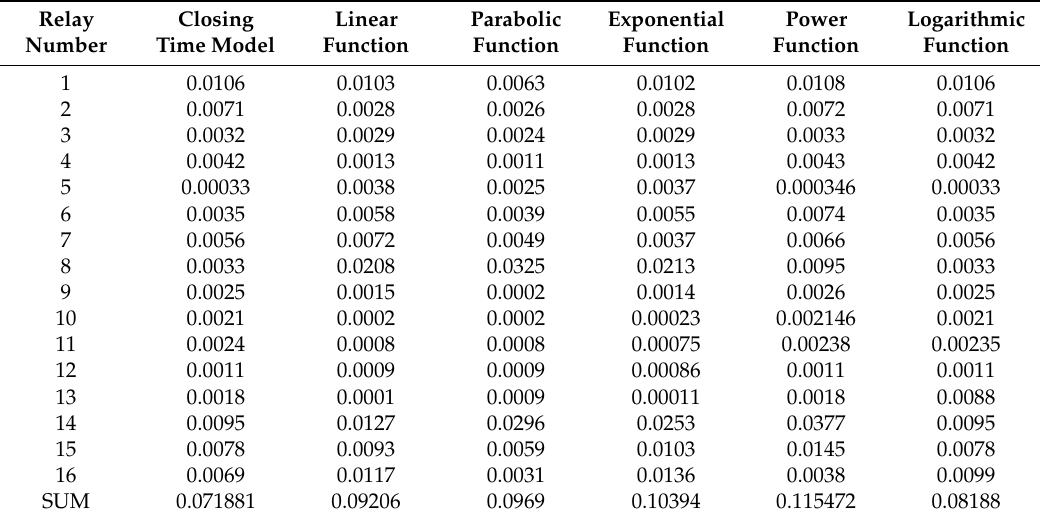
Table 4. The residual sums of squares.